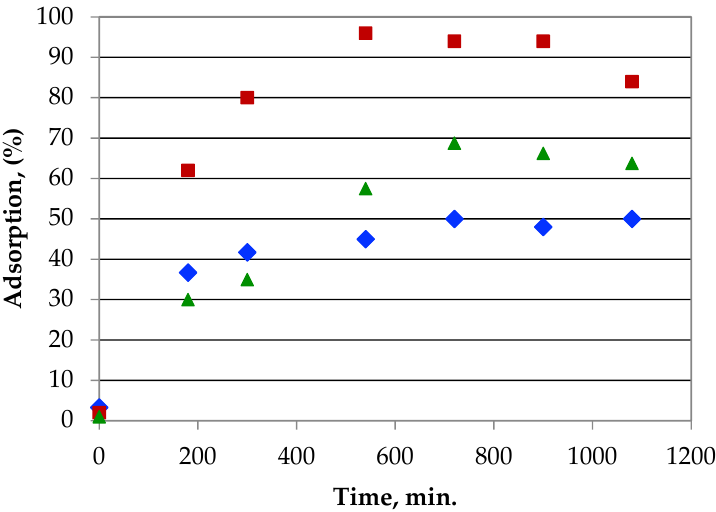
Figure 8. Photographs of the GS 2:1 hybrids after adsorption of metal ions: ( a ) copper(II), ( b ) lead(II), ( c ) cadmium(II).